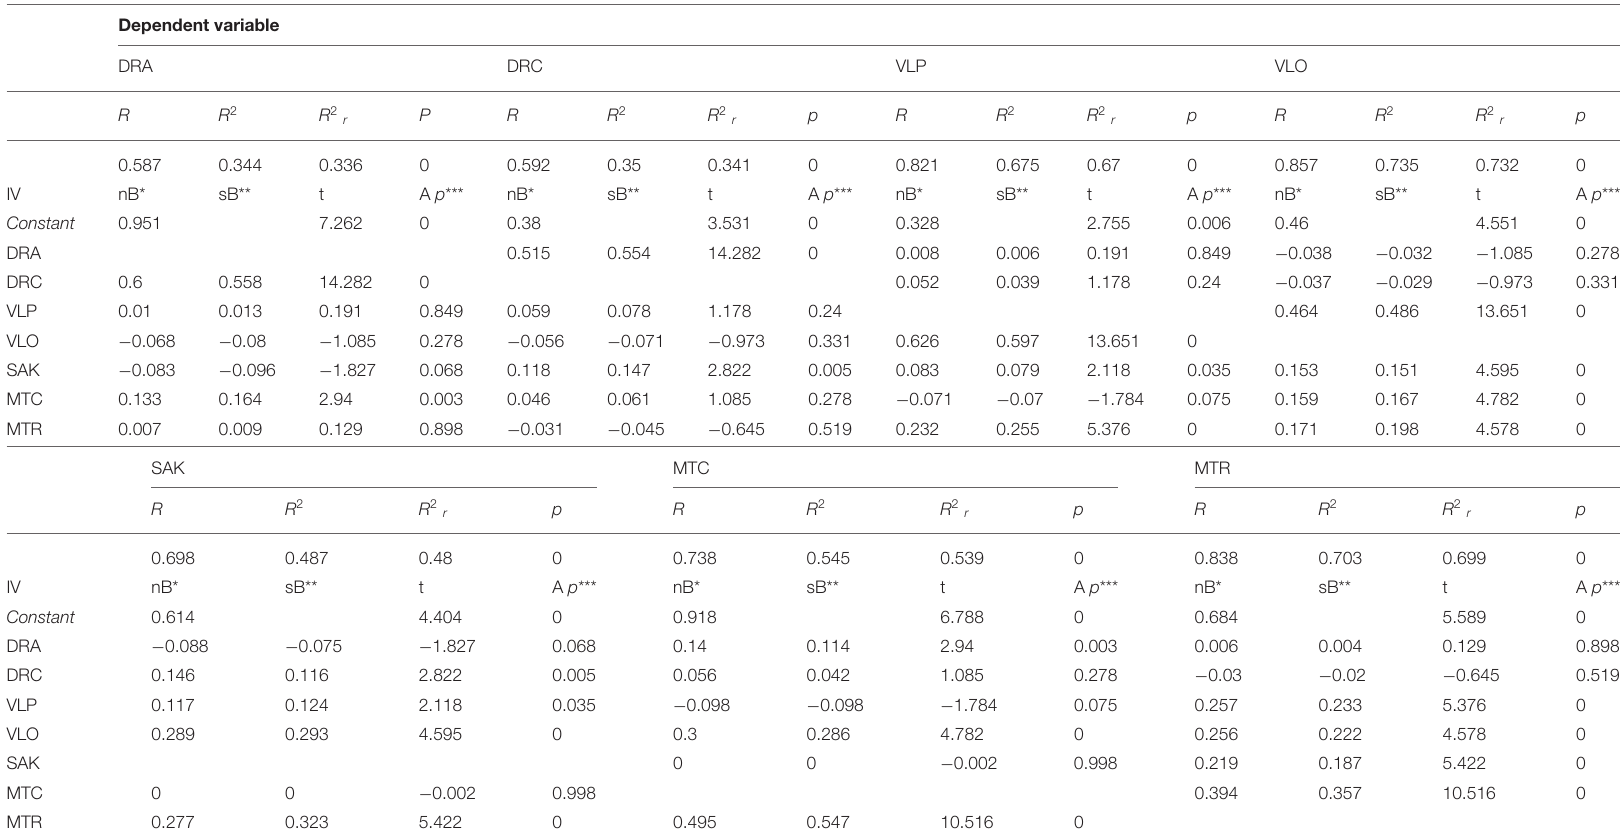
TABLE 4 | Relationships between the subscales of experiences of destructive relationships at work and of motives for seeking spiritual assistance in religious organizations ( N = 4